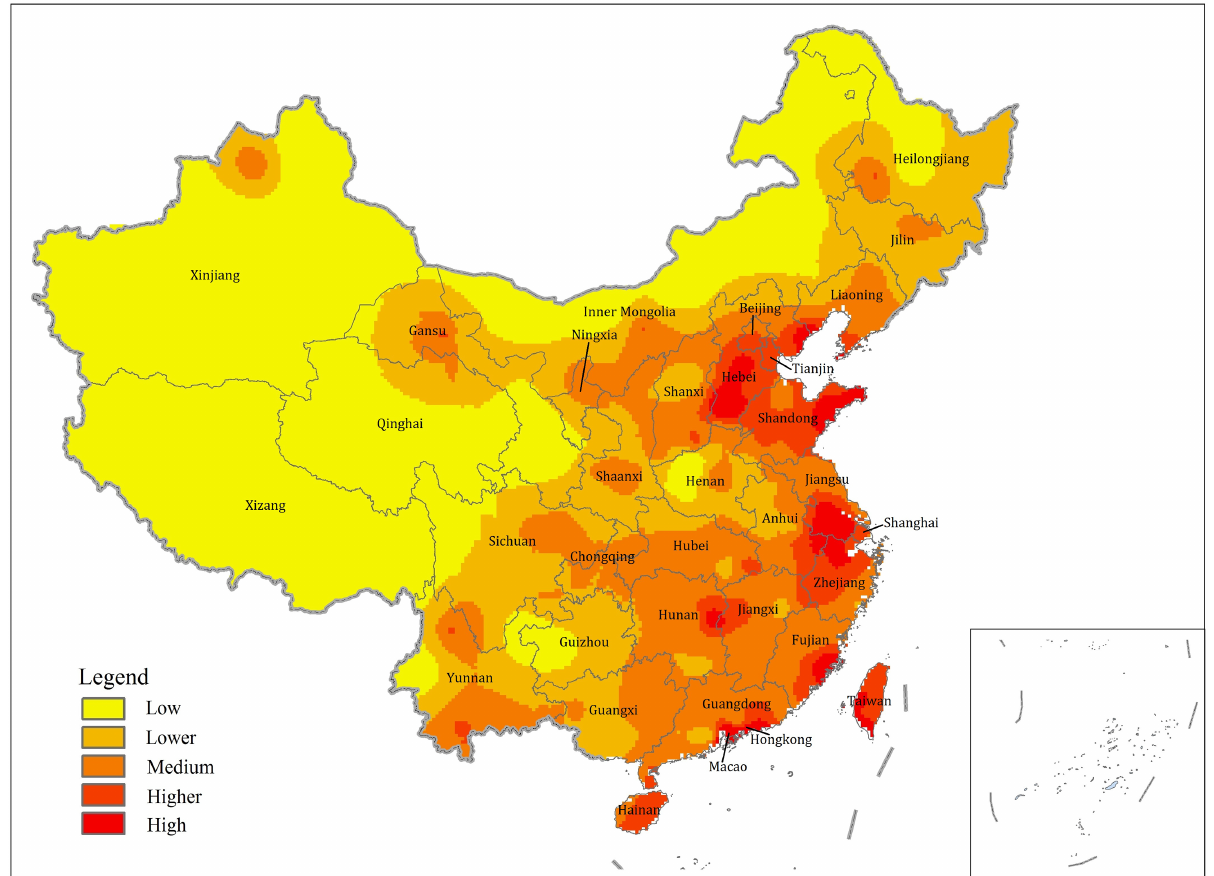
Fig 1. Distribution of municipal infrastructure development in China prefecture-level